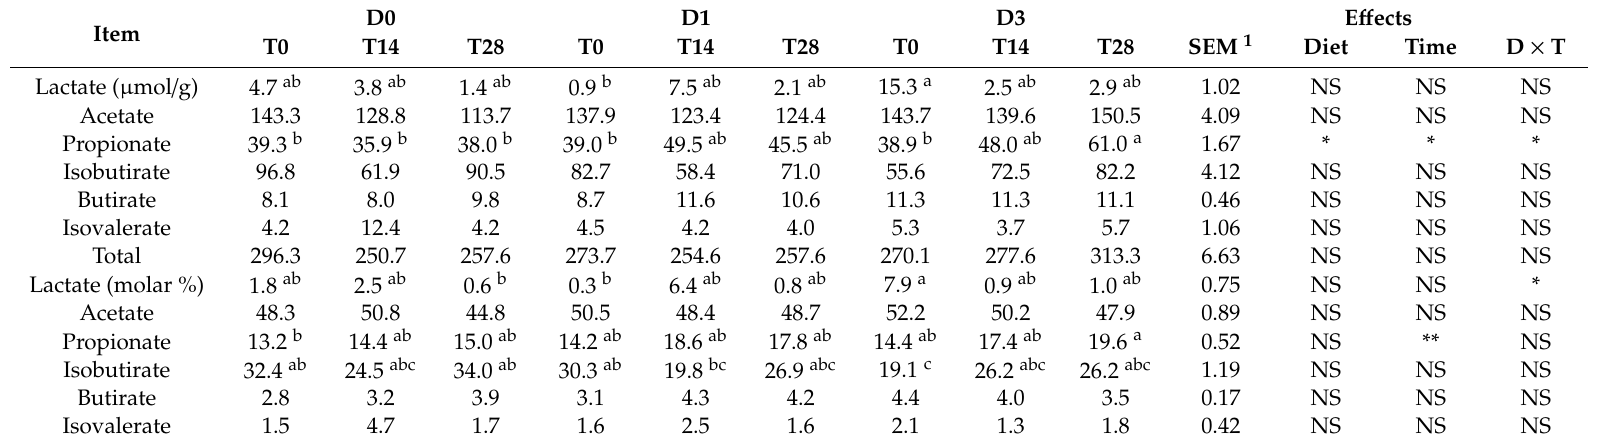
Table 1. Mean concentrations and molar proportions of lactate and volatile fatty acids in the feces of the dogs fed diet without supplementation of grape proanthocyanidins (D0) or supplemented with 1 mg / kg live weight (D1) or 3 mg / kg live weight (D3) of grape proanthocyanidins at the beginning of the study (T0) and after 14 (T14) and 28 (T28) days of